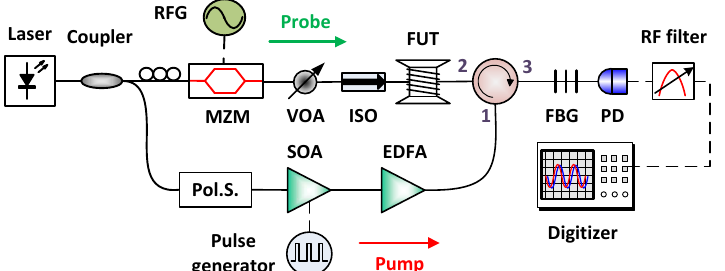
Figure 3. Experimental setup: RFG: radio frequency generator, MZM: Mach Zehnder modulator, VOA: variable optical attenuator, ISO: isolator, FUT: fiber under test, CIR: circulator, FBG: fiber Bragg grating, Pol.S: polarization scrambler, SOA: semiconductor optical amplifier, EDFA: Erbium-doped fiber amplifier, PD: